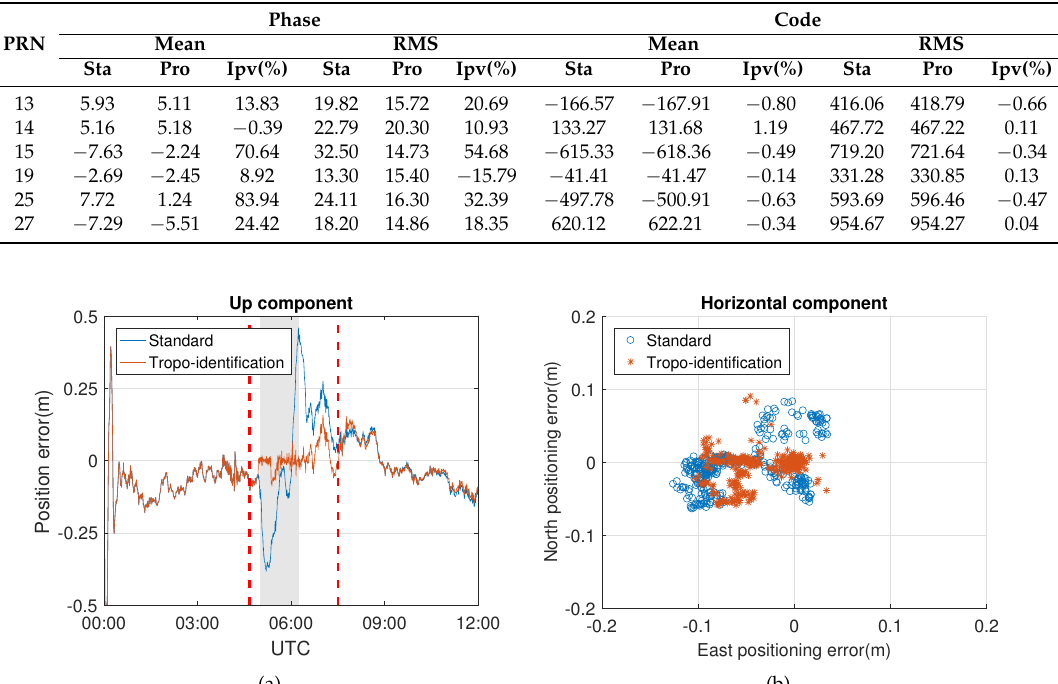
Table 3. Means and RMSs of the phase and code residuals of the satellites being identified with model error during Event 2.